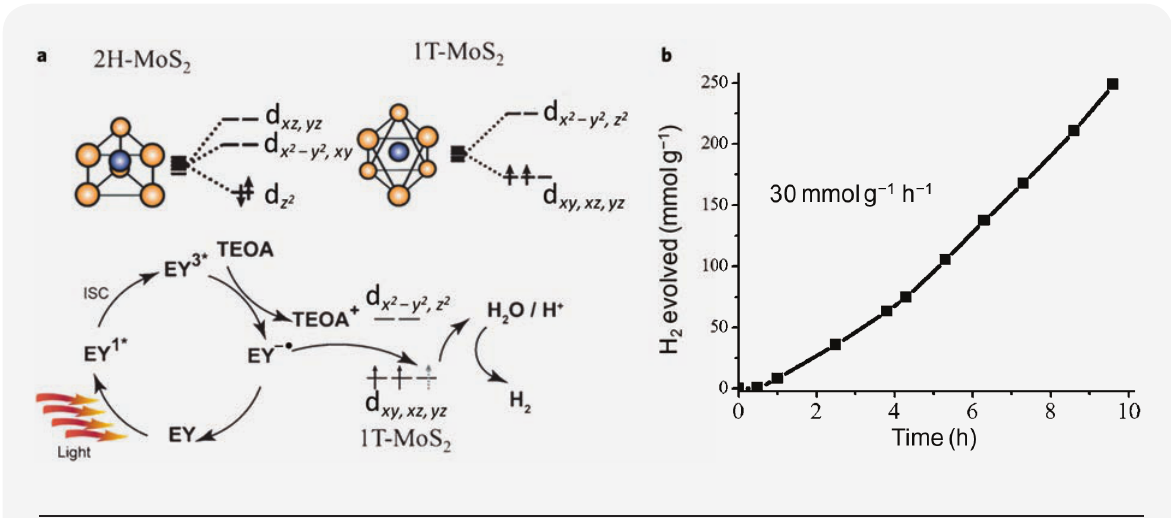
Figure 9. (a) Electronic confi guration of 2H-MoS 2 and 1T-MoS 2 induced by the crystal-fi eld splitting and proposed mechanism of hydrogen evolution on 1T-MoS 2 . (b) Time course of H 2 evolved by 1T-MoS 2 . Reproduced with permission from Ref. 23. Copyright 2013, Wiley-VCH Verlag GmbH & Co. KGaA,